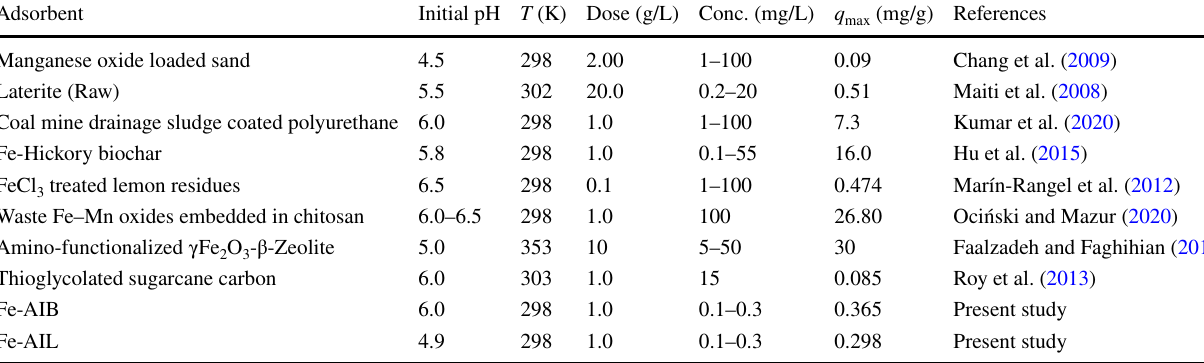
Table 8 Comparison of adsorption capacity of various adsorbent adsorbents used for As (V) remediation